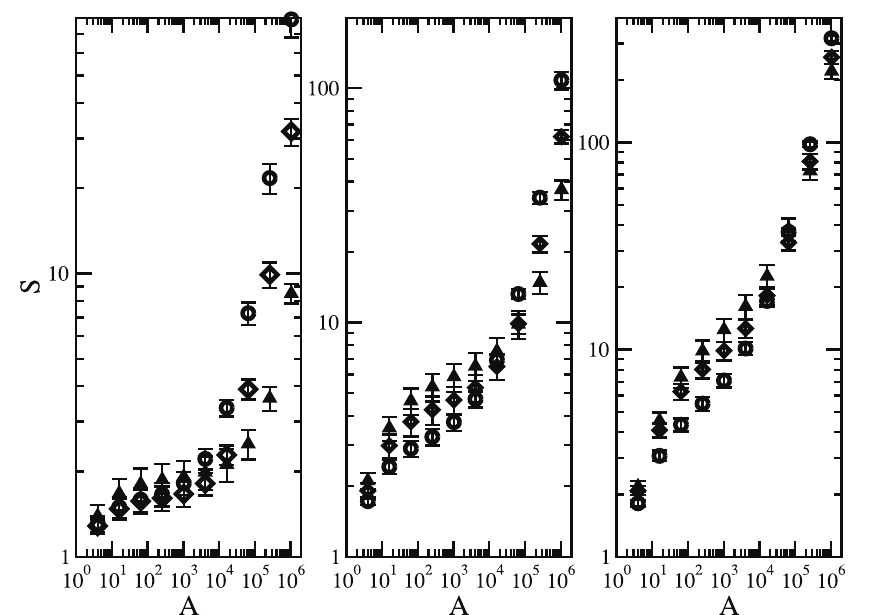
Figure 6. Effect of dispersal on the species-area relationship. Number of species S is plotted against area for p ~ 0 : 5 and dispersal parameter K ~ 7 and distinct values of the clumping parameter H : H ~ 0 : 1 (open circles), H ~ 0 : 5 (open diamonds) and H ~ 0 : 9 (filled triangles). Left panel: n ~ 1 | 10 { 6 , middle panel: n ~ 1 | 10 { 5 and left panel: n ~ 1 | 10 { 4 . The data points represent an average over 20 independent runs. The error bars correspond to one standard error. doi:10.1371/journal.pone.0066495.g006 in state w indicates that it is occupied by one individual of species system reaches an equilibrium regime. Although the model w , whereas the state 0 denotes an unsuitable habitat. The provides some dispersal among next-nearest cells, it is feasible to population evolves according to the above dynamics until the allow long-range dispersal [29–32], as we will briefly discuss in